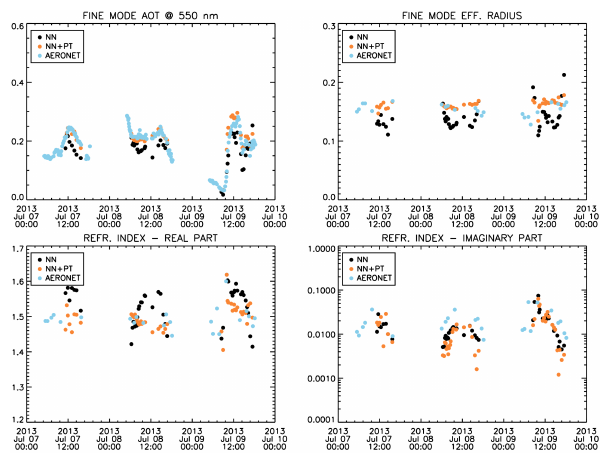
Figure 10. Fine-mode AOT (upper left) and effective radius (upper right) and AOT-weighted real (lower left) and imaginary part (lower right) of the refractive index estimated using the NN alone (black circles), the NN + PT scheme (orange circles), and reference values from AERONET (sky-blue